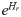
The amino-acid preferences are modestly correlated among experimental replicates, but the sites tolerate similar numbers of amino acids and prefer similar amino acids across replicates.(A) Correlations between the site-specific amino-acid preferences from each replicate. (B) Correlations between the effective number of amino acids tolerated per site. For each site r, the effective number of tolerated amino acids is eHr, where Hr is the Shannon entropy of that site’s amino-acid preferences. This number ranges between 1 and 20, with 20 indicating all amino acids are preferred equally and 1 indicating only a single amino acid is preferred. (C) Correlations between the preference-weighted hydrophobicities. For each site r, the preference-weighted hydrophobicity is ∑a
πr,a × Xa where πr,a is the preference of r for amino acid a, and Xa is the Kyte-Doolittle hydropathy [90] of a. The fact that both the effective number of tolerated amino acids and the hydrophobicities are more correlated than the amino-acid preferences means that when different amino acids are preferred at a site in different experimental replicates, the number and chemical properties of the preferred amino acids are similar. Each plot shows the Pearson correlation coefficient and associated P-value. Similar data for replicates 3b-1 and 3b-2 are in S6 Fig. The plots in this and subsequent figures show all 20 amino-acid preferences for each site; although only 19 of these preferences are independent parameters, all 20 values are shown because otherwise the correlation will depend on which value is excluded.